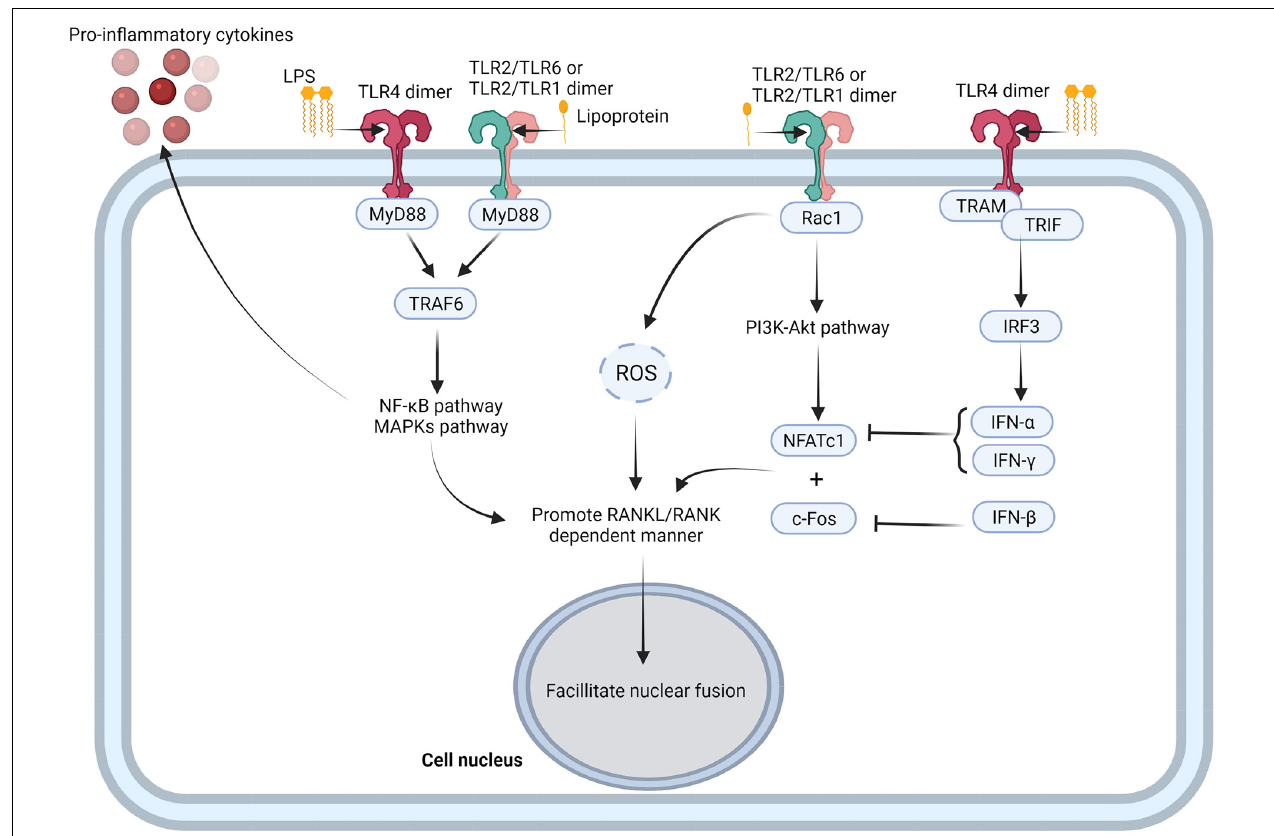
FIGURE 3 | TLRs-mediated activation of osteoclastogenesis. TLR4 and TLR2 combine with PAMPs, such as LPS and lipoprotein, to form TLR4 dimer, TLR2/TLR1, and TLR2/TLR6 dimer. TLRs recruit TRAF6 with MyD88, and activate NF- κ B and MAPK pathway (Souza and Lerner, 2019). NF- κ B and MAPK pathways not only promote inflammatory cytokine production from osteoclast precursor cells, but also promote RNAKL/RANK dependent manner and facilitate nuclear fusion of osteoclast precursor cells (Souza and Lerner, 2019). TLR2/TLR1 dimer and TLR2/TLR6 dimer also activate PI3K-Akt pathway through recruitment of Rac1 and facilitate expression of NFATc1 (Shen et al., 2010; Kanzaki et al., 2016), while TLR4 dimer promotes expression of IFN- α and IFN- β though TRAM/TRIF/IRF3 signaling axis to negative regulate NFATc1 (Liu et al., 2016; Kwon et al., 2019). Figure was created using BioRender.com.